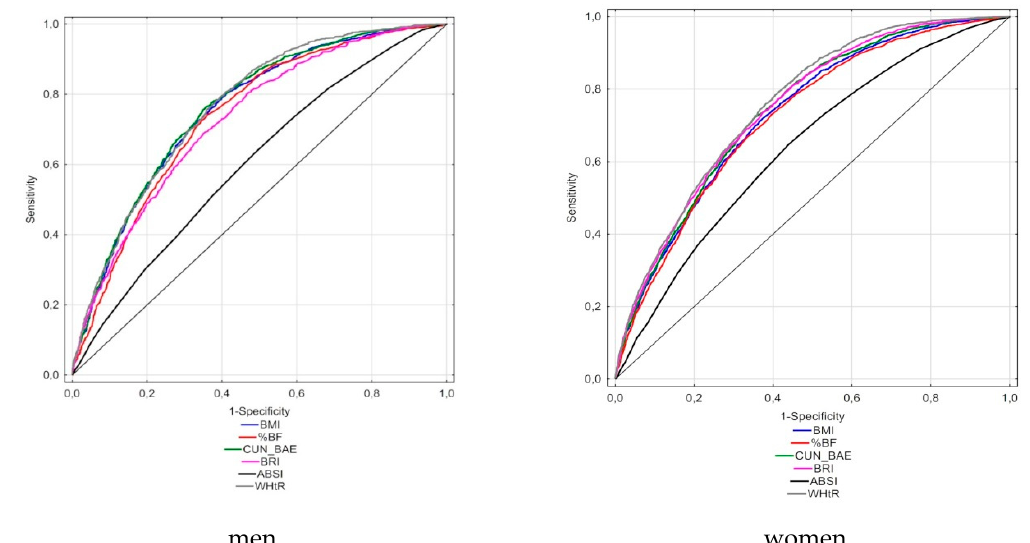
Figure 1. Receiver-operating characteristic curves of anthropometric indices to identify men and women with MetS (MetS classic: three or more components out of five).